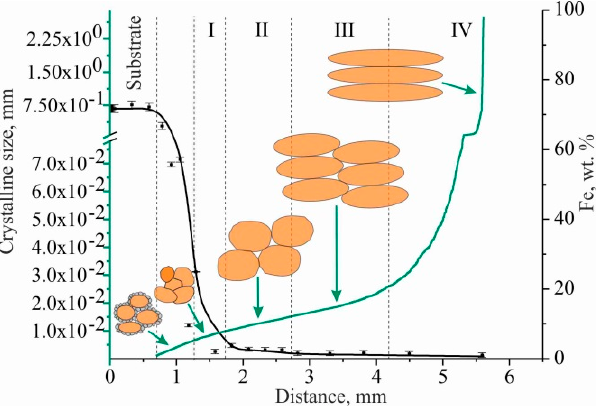
Figure 17. Schematic of the texture formation of C-type copper block based on the dependence of grain size on the Fe content with the distance from the substrate. Green line is crystalline size, black line is content of Fe.